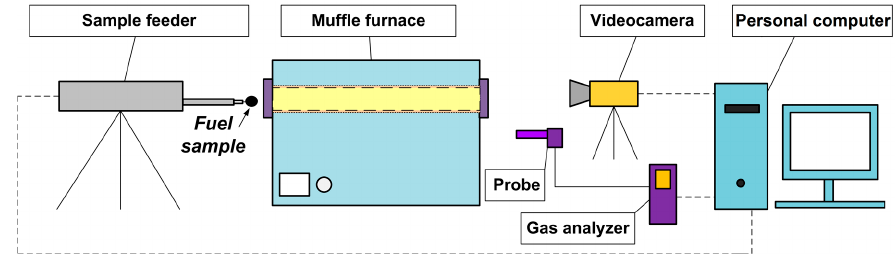
Figure 1. Scheme of experimental setup.